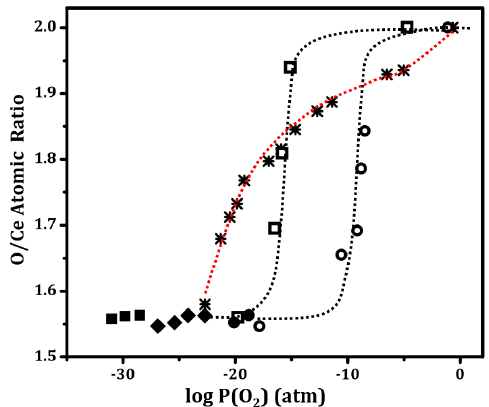
Figure 5. O/Ce ratio as a function of P(O 2 ) for 20Ce 0.5 Zr 0.5 O 2 –Al 2 O 3 , determined by flow titration, at temperatures (  )—773K, ( ∎ )—873 K, and ( ● )—1073 K. The ( ○ ) symbol shows the isotherm for 20Ce 0.5 Zr 0.5 O 2 –Al 2 O 3 , determined by coulometric titration at 1073 K. Oxidation isotherm result